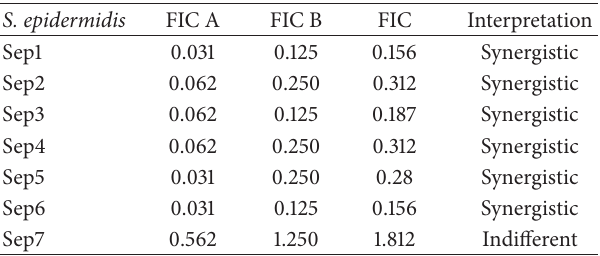
Table 4: Interactions of essential oil from Salvia officinalis with oxacillin in effect on clinical strains of methicillin-resistant S. epidermidis . S. epidermidis FIC A FIC B FIC Interpretation Sep1 0.031 0.125 0.156 Synergistic Sep2 0.062 0.250 0.312 Synergistic Sep3 0.062 0.125 0.187 Synergistic Sep4 0.062 0.250 0.312 Synergistic Sep5 0.031 0.250 0.28 Synergistic Sep6 0.031 0.125 0.156 Synergistic Sep7 0.562 1.250 1.812